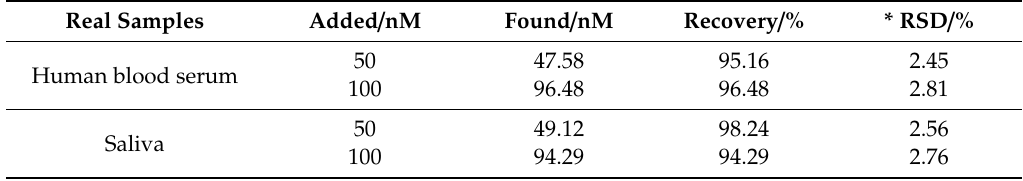
Table 2. Determination of 4-NQO in biologic samples at NiCo 2 S 4 -Ms / GCE modified electrode. Real Samples Added / nM Found / nM Recovery / % * RSD / % 50 47.58 95.16 Human blood serum 100 96.48 Saliva